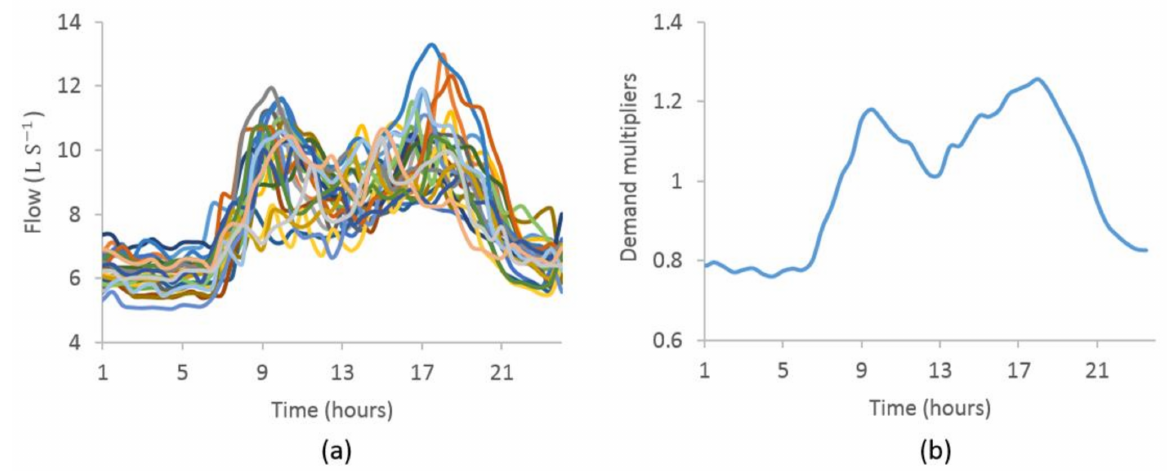
Figure 4. ( a ) Flow pattern on different days during the simulation period and ( b ) estimated average demand multipliers from flow